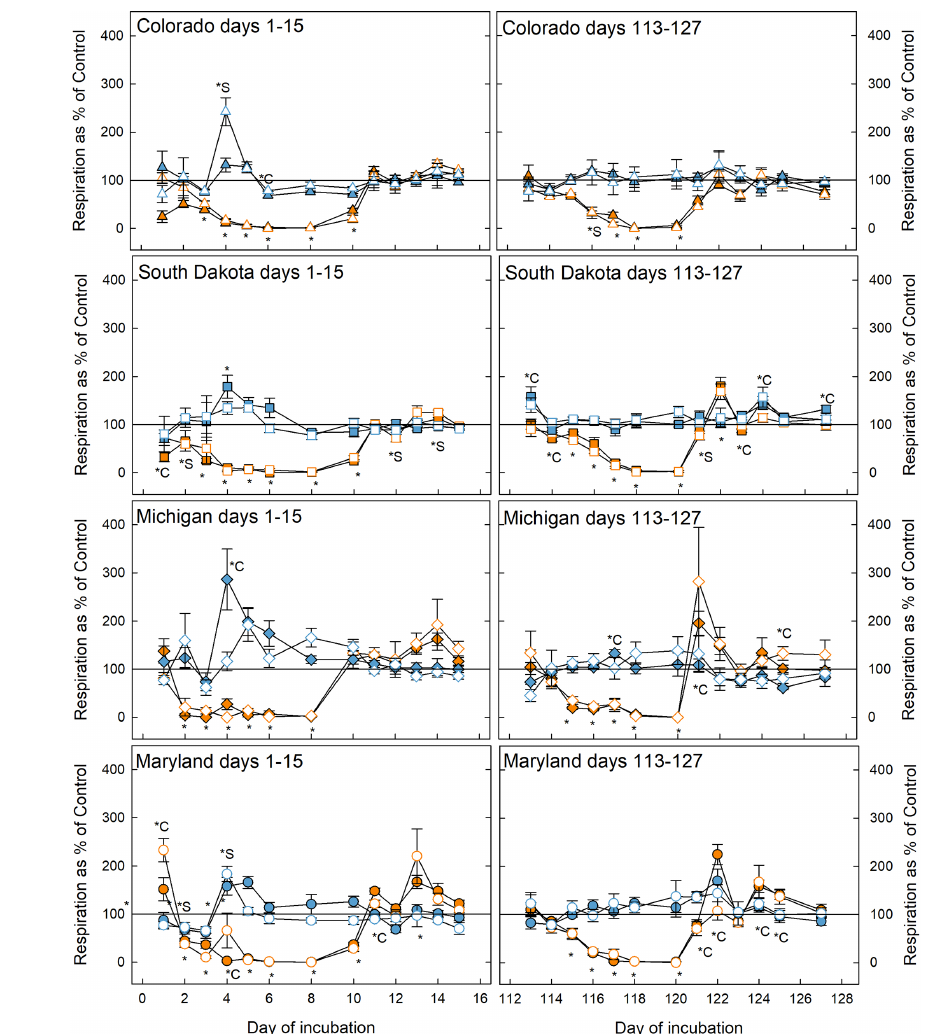
Figure 2. Soil respiration rates during the first (left panels) and fifth (right panels) stress cycles relative to the control at 50% WHC. Blue symbols represent microcosms exposed to flooding and orange symbols represent drought treatment. Open symbols are simple rotations and filled symbols are the complex rotations at the respective sites. The ∗ symbol indicates that the treatment significantly changed respiration with respect to the control; ∗ C and ∗ S mean that only soil samples from complex or simple rotations, respectively, had significantly different respiration rates than the respective control. If indicators for significance are above the graphs, they refer to the flooding treatment; below, they refer to the drought treatment. Significant difference was assumed at p < 0 .